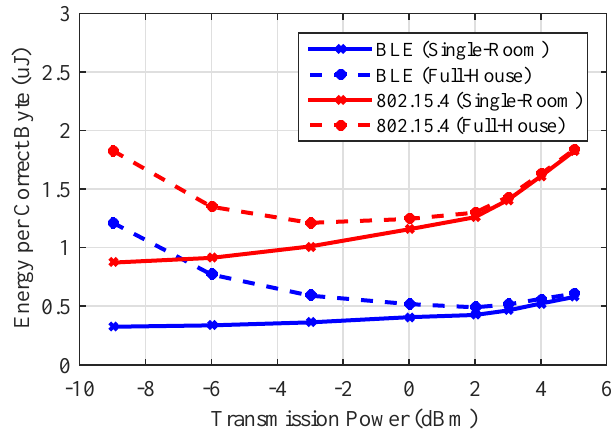
Figure 8. Energy efficiency for various transmission power levels when the transmitter and the receiver are in the same room (single-room coverage) and separated by two walls (full-house